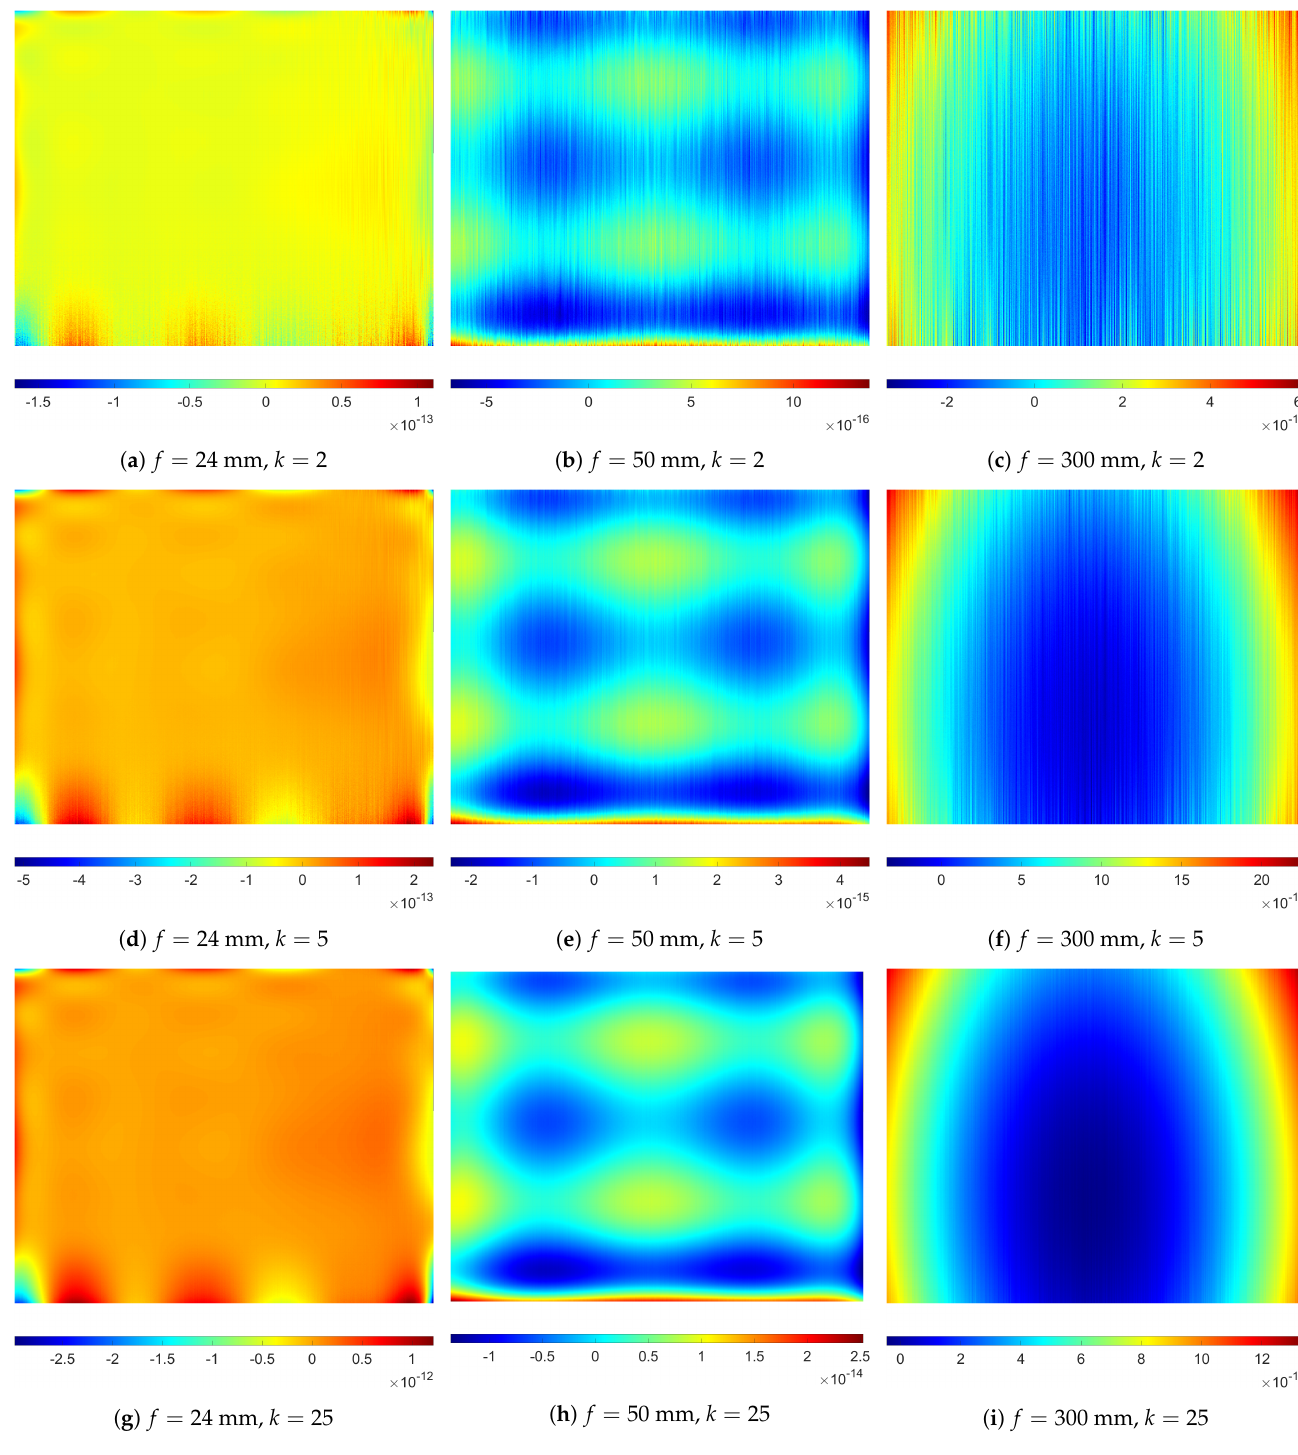
Figure 5. Mean errors ¯ ε ( i , j ) related to using SNILP in an iterative manner for different numbers of repetitions k , results for image I V of size 1280 × 1024 pixels contained with Gaussian mixture noise (A5) for σ add = 5% and σ multi =